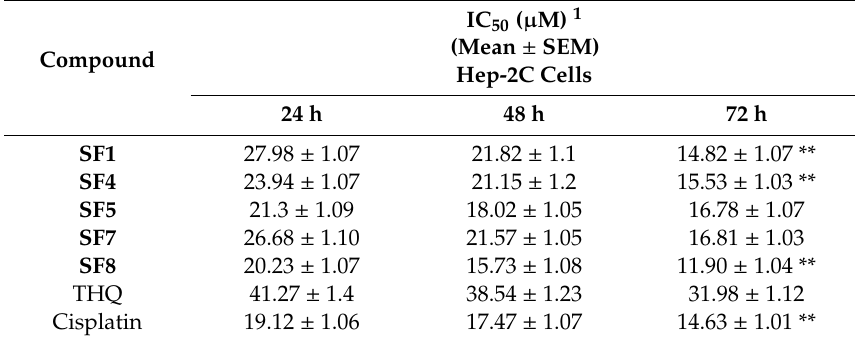
Table 5. IC 50 data of synthetic compounds at 24, 48 and 72 h.